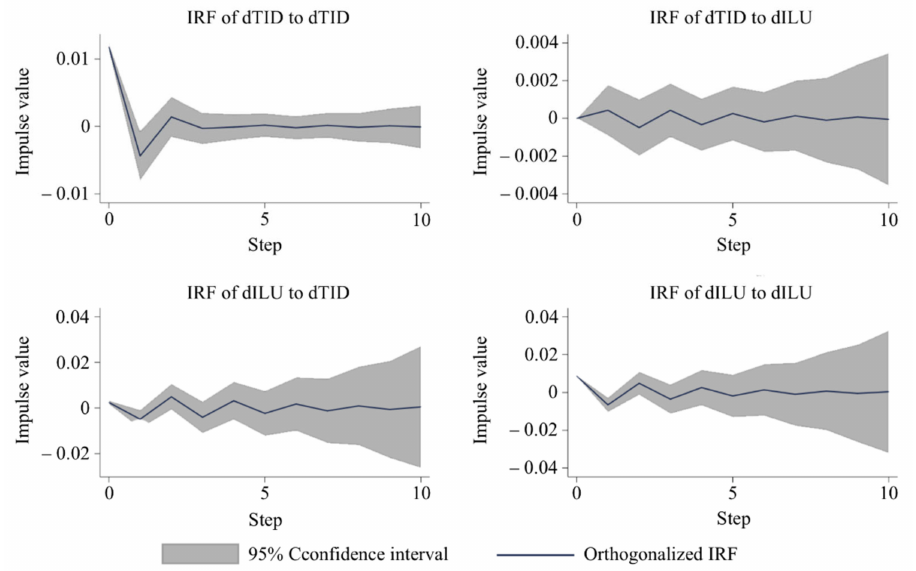
Figure 10. Impulse response